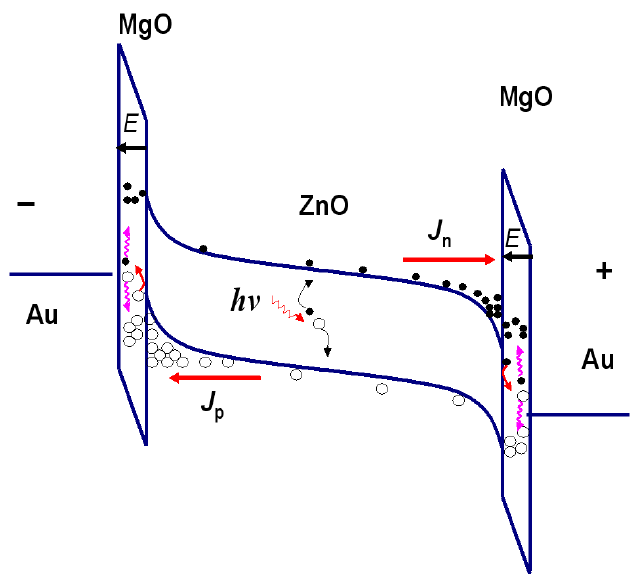
Figure 5. The schematic illustration of the band alignment of the MISIM structured ZnO photodetector showing the occurrence of carrier multiplication via the impact ionization